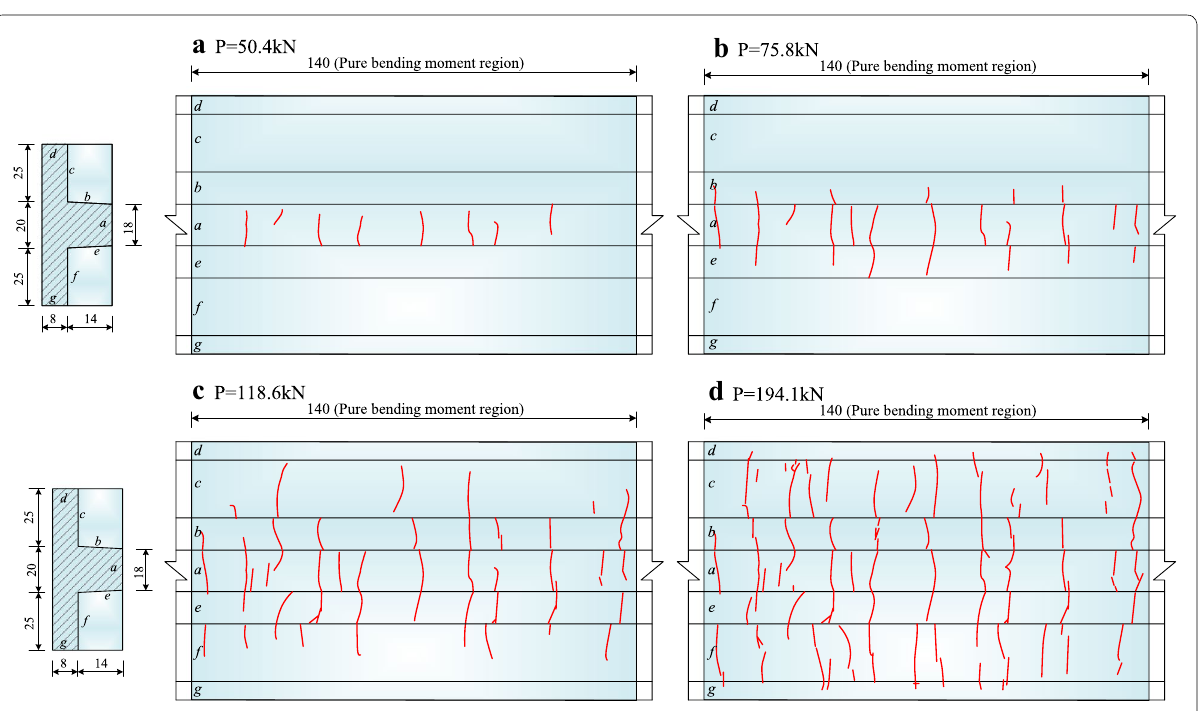
approached to the peak load of the specimen, the crack localization with excessive crack width (i.e. higher than 4 mm) and rebars yielding was observed, and thus the specimen was regarded as failure in this investigation.